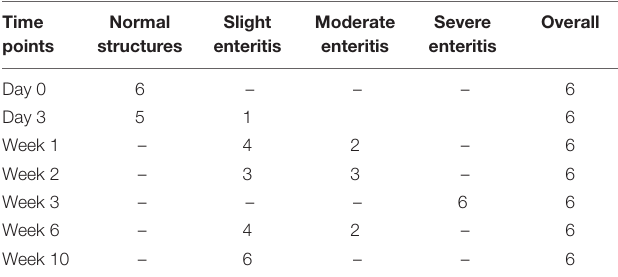
TABLE 4 | Distal intestinal histology changes statistics in the 7S& FM